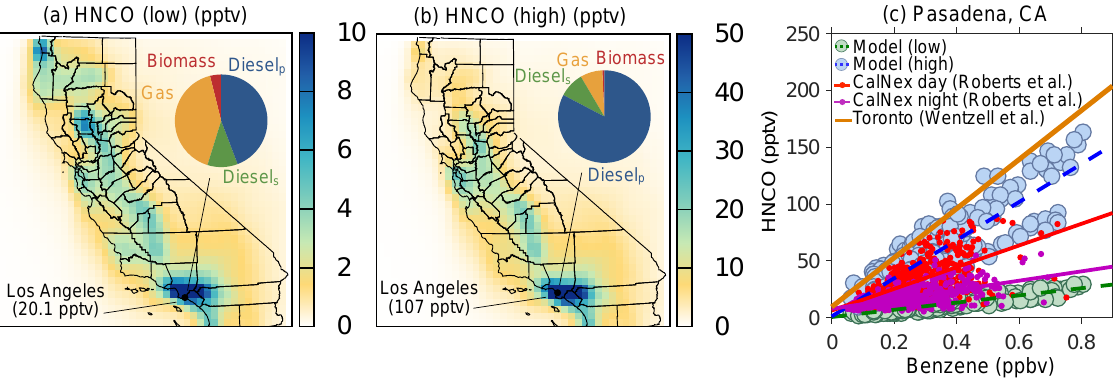
Figure 4. (a) Low and (b) high estimates of the 14-day averaged ground-level concentrations of HNCO from the 24km simulations. The low and high estimates used two different primary emissions and photochemical production parameterizations for diesel engines (see Table 1). The color scales in panels (a) and (b) have been truncated at 10 and 50pptv, respectively, to visualize the statewide variability in HNCO concentrations. We note that in both the panels, the HNCO concentrations in the Los Angeles region exceed the concentrations captured on the color scale. (c) 14-day averaged concentrations of HNCO regressed against benzene over the South Coast Air Basin from the 8km simulations; also includes observations from Wentzell et al. (2013) for Toronto, 2012, and from Roberts et al. (2014) and Borbon et al. (2013) for Pasadena, 2010, during